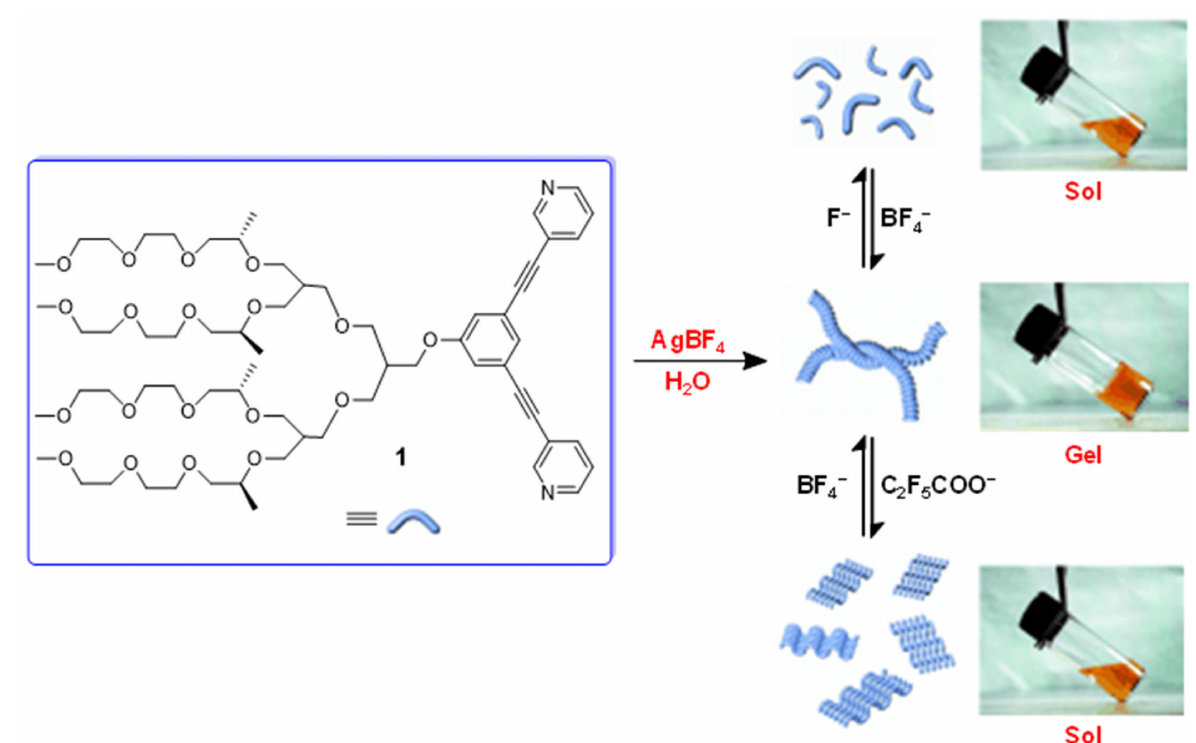
Figure 1. Schematic representation of reversible polymerization and reversible conversion between folded and unfolded conformations of a coordination chain upon counteranion exchange. Reprinted with permission from Ref. [36]. Copyright (2005), John Wiley and